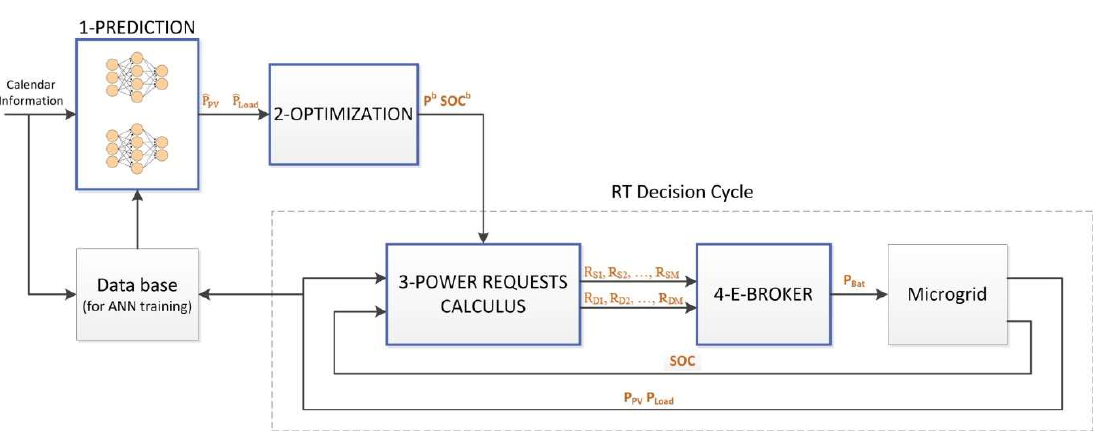
Figure 2. Proposed method.